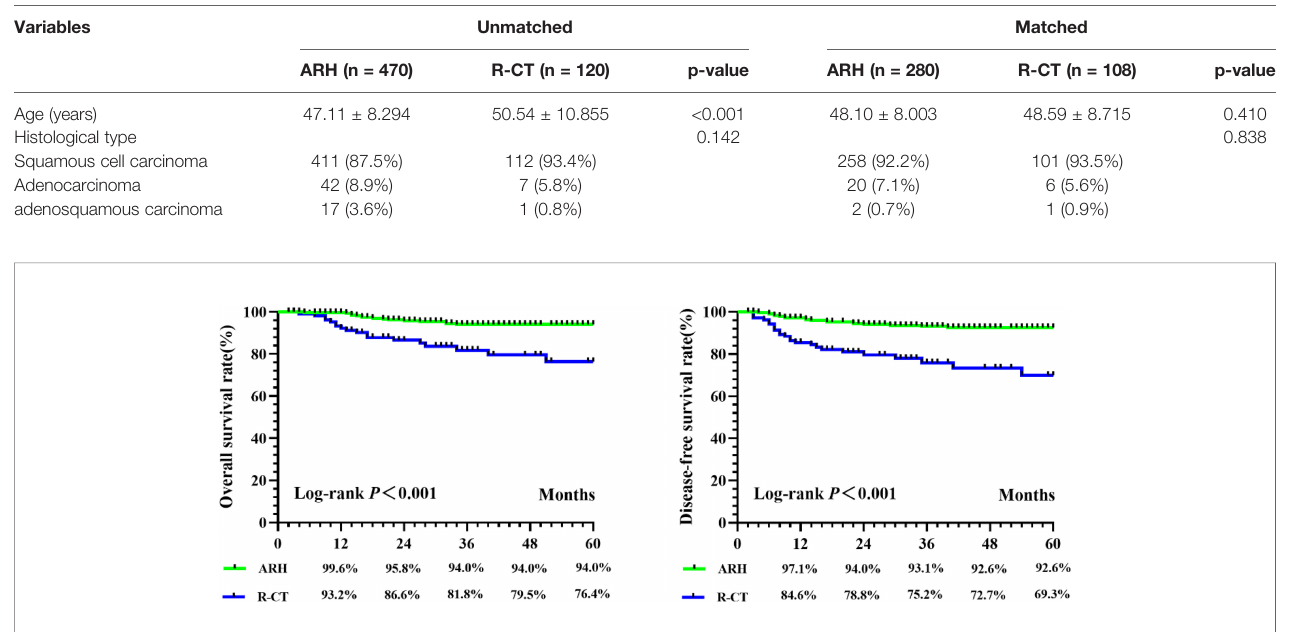
FIGURE 2 | The 5-year OS and DFS in ARH group and R-CT group before